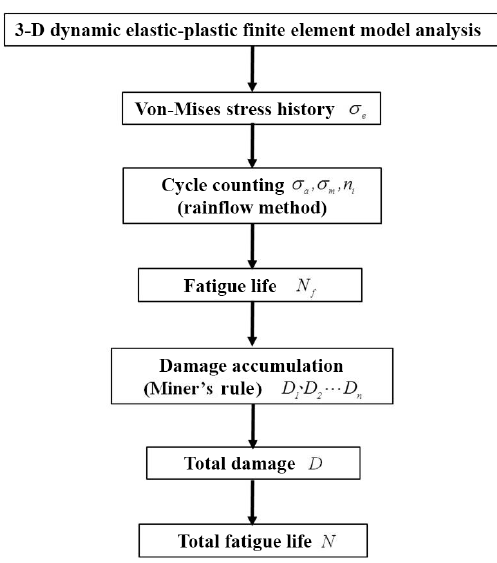
Figure 16. Fatigue life estimation of redesigned